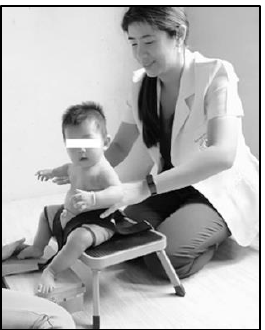
Figure 1. Segmental Assessment of Trunk Control (SATCo) includes 7 trunk